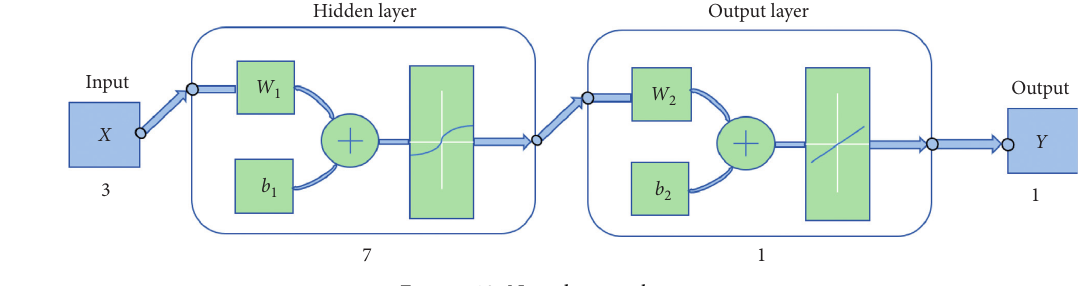
Figure 10: Neural network structure. Table 6: Performance comparison of each